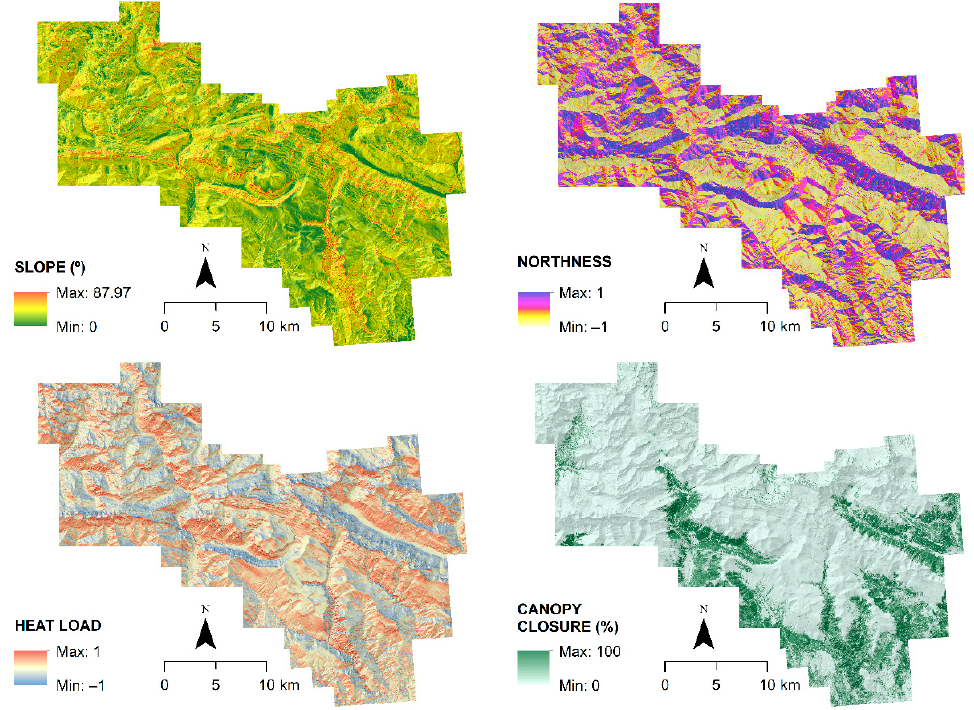
Figure 3. Topographic and environmental variability in the study area, corresponding to 4 of the 11 variables analyzed in this study: slope, northness, heat load, and canopy